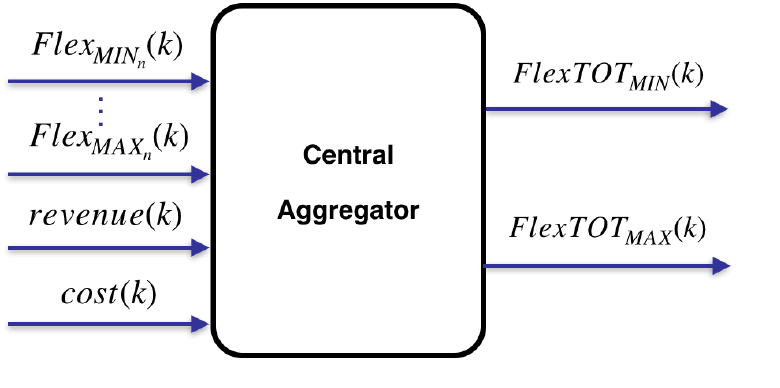
Figure 10. Central Aggregator